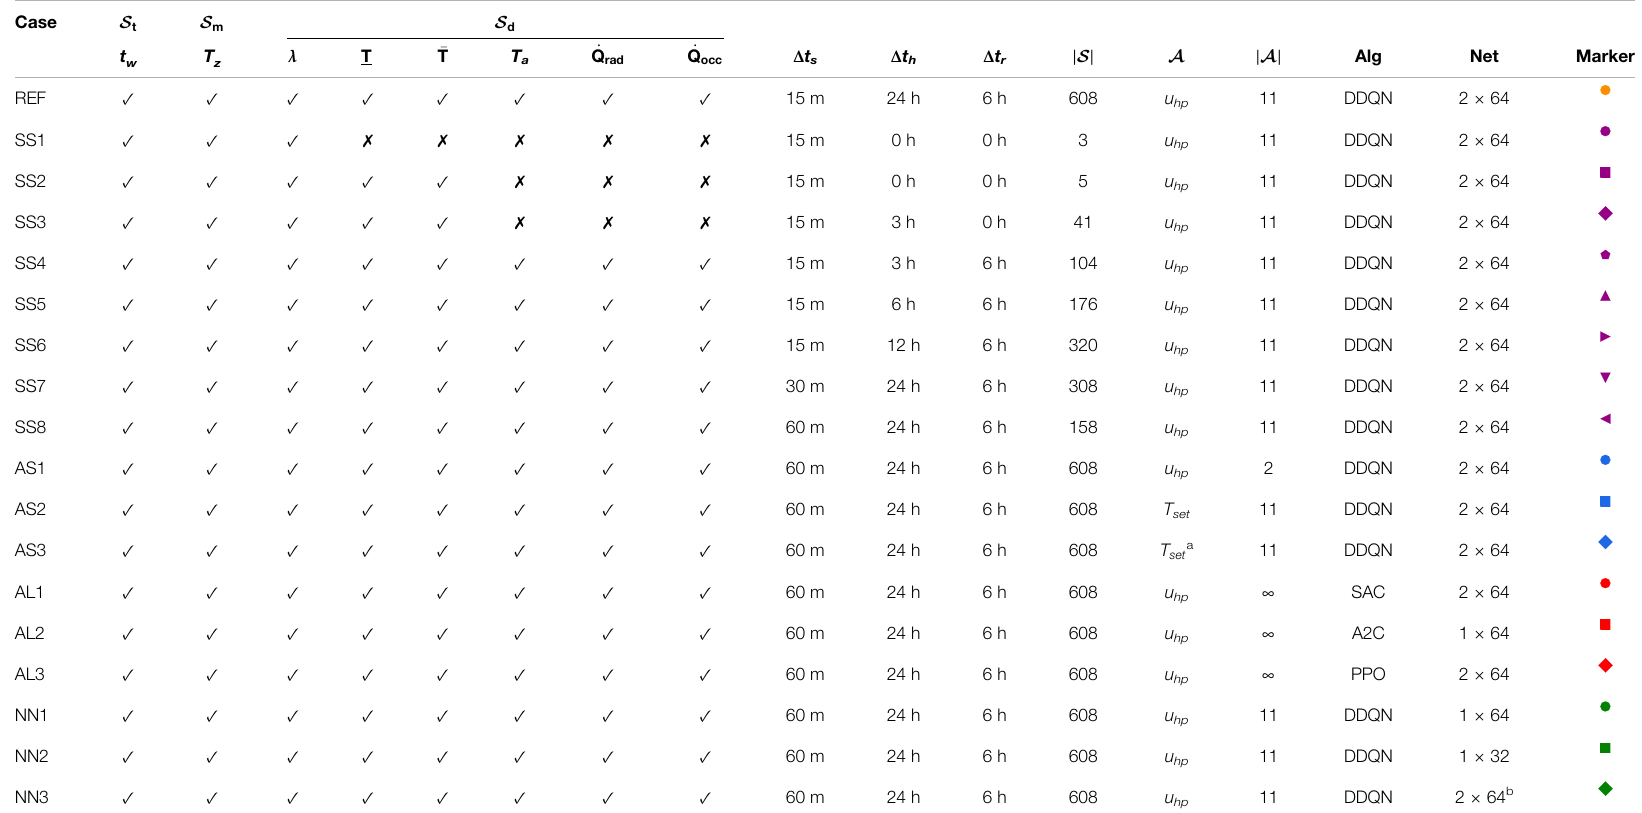
TABLE1| ConsideredRLagentcon fi gurationsforcomparison.Thestatespacerepresentationisgroupedinthesetoftimevariables S t ,thesetofmeasurementvariables S m andthesetofdisturbances S d .Algindicatesthe learning algorithm, and Net the network architecture used as a function approximator. The markers anticipate the symbols that are used to depict the results in the following